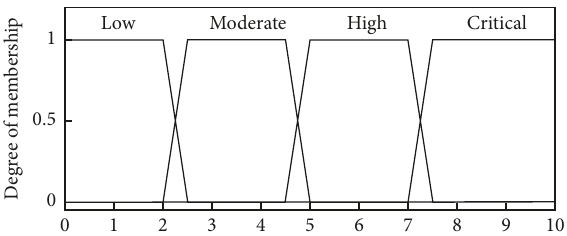
Figure 9: Input variable MF-furans content factor (FF).